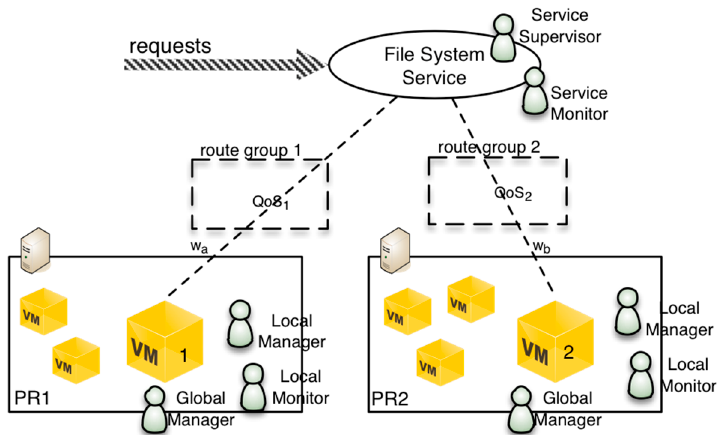
Figure 5. Evaluation of the case study—status during the initial period.